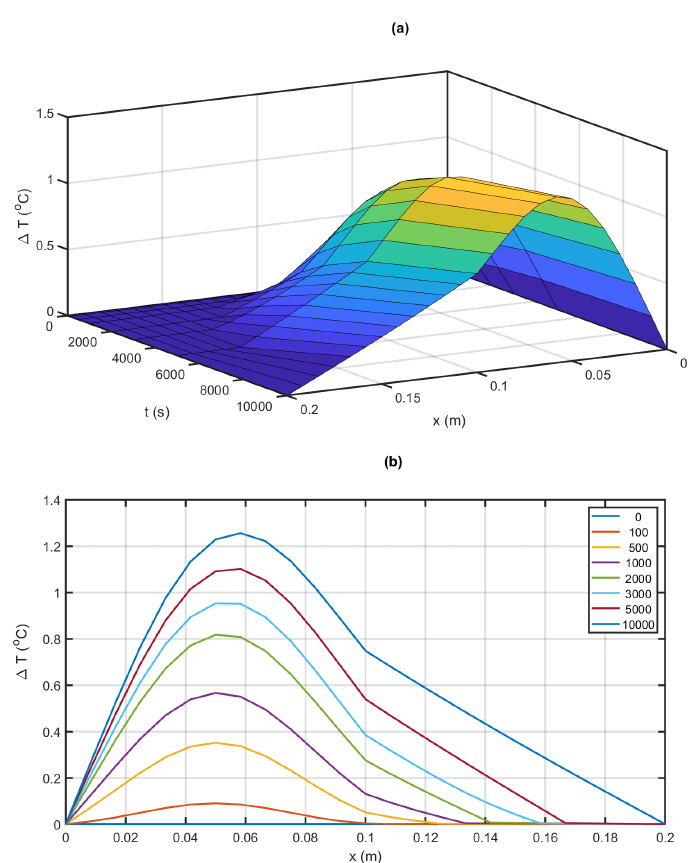
Figure 26. Temperature distribution inside BAW + PCM cell ( a ) profile plot ( b ) surface